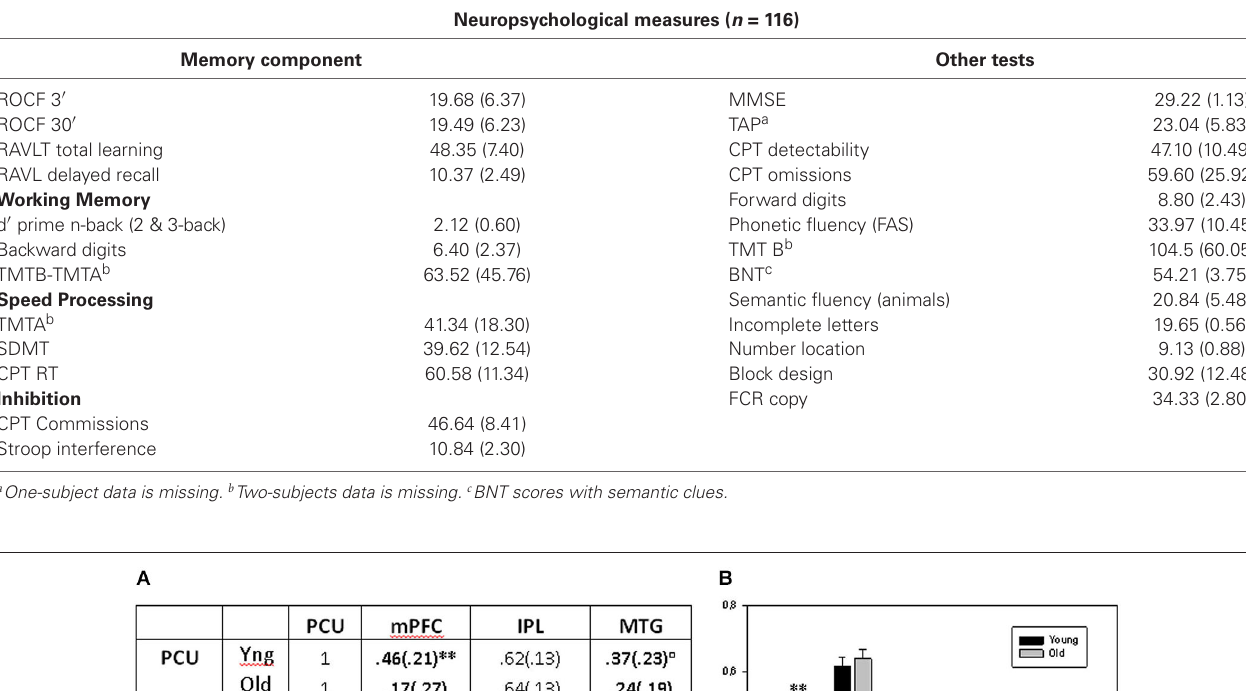
Table 3 | Neuropsychological measures for sample 1 .